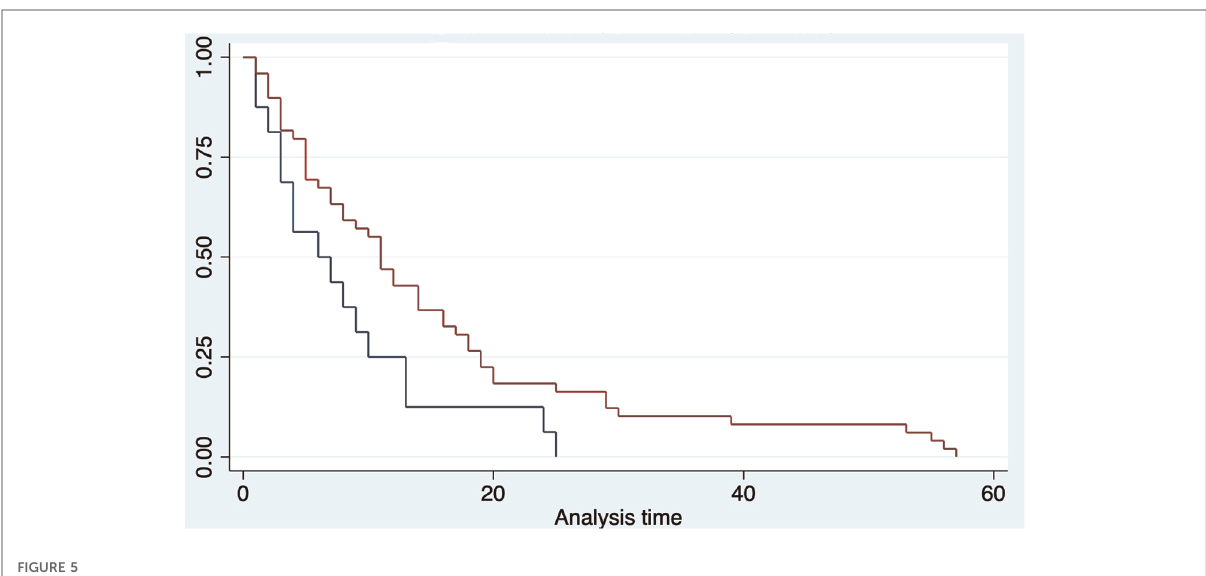
FIGURE 5 Kaplan – meier survival